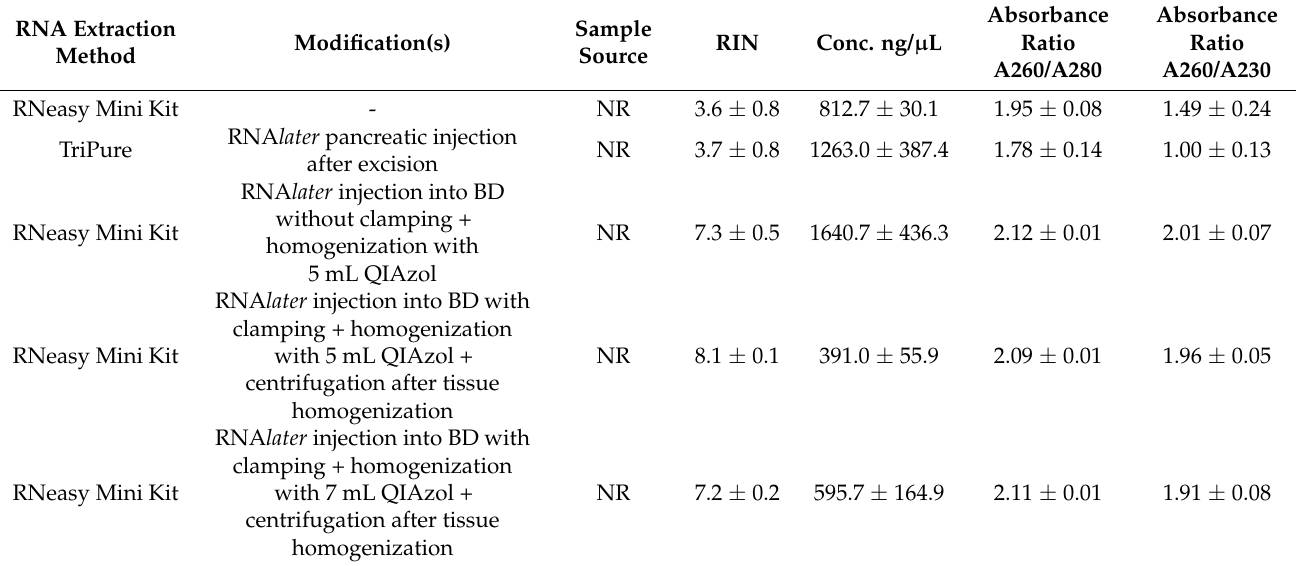
Table 2. Quantification of RNA from rat pancreas following different excision techniques and extraction protocols.